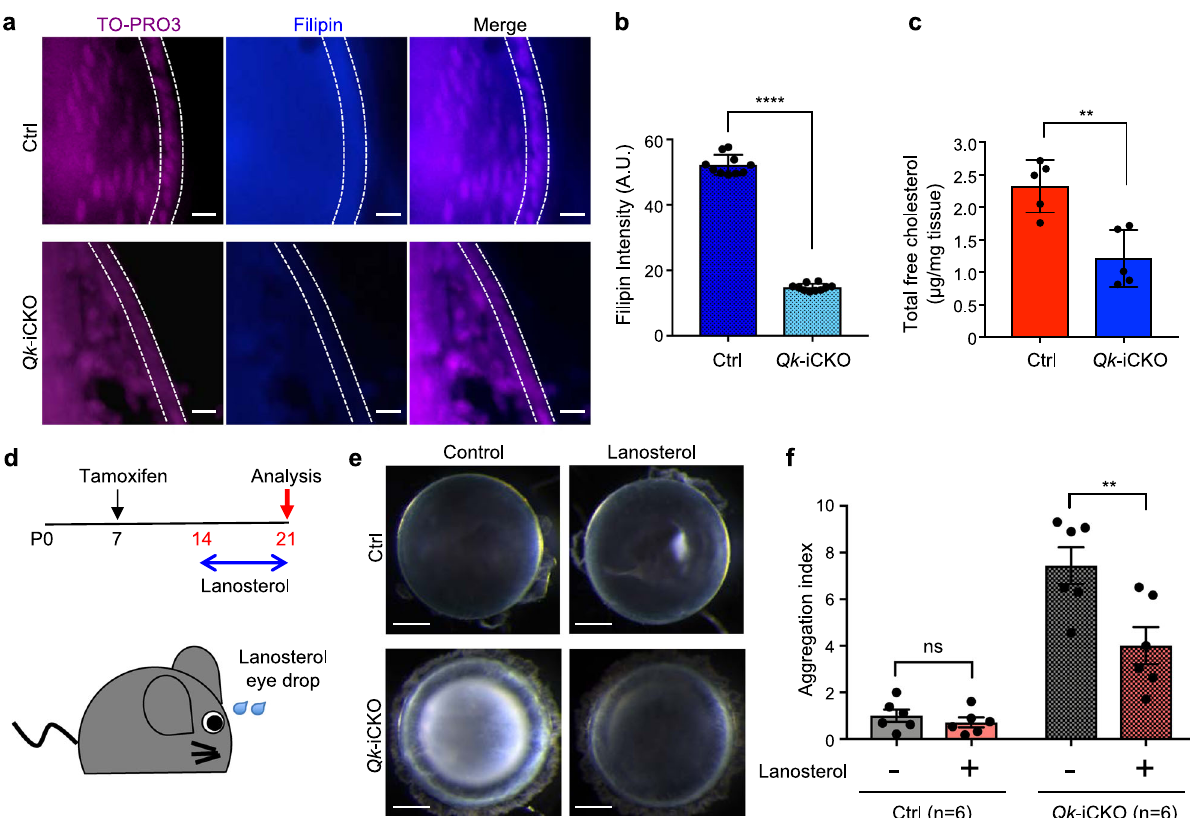
Fig. 3 Cholesterol levels are decreased in Qki-depleted lenses, and sterol supply alleviates the cataract phenotype in the lenses of Qk -iCKO mice. a Filipin (blue) staining of lens cells from frozen sections of the eyes of Ctrl and Qk- iCKO mice at P19. TO-PRO3 (magenta): nuclei. Scale bar: 10 μ m. b Quanti fi cation of fi lipin intensity (A.U.) in the regions between the white dotted lines in Ctrl and Qki-depleted lenses shown in a . **** p < 0.0001 (two- tailed unpaired t -test). The results are presented as means with SD. 10 cells from the images shown in a are counted for quanti fi cation. Each dot represents the intensity of individual cells. c Quanti fi cation of total free cholesterol levels ( μ g/mg tissue) in lenses isolated from Ctrl ( n = 5) and Qk -iCKO ( n = 5) mice at P19. p = 0.0032, ** p < 0.01 (two-tailed unpaired t -test). The results are presented as means with SD. d Timeline and schematic of lanosterol-based treatment in mice. e Representative images of lenses isolated from Ctrl and Qk -iCKO mice given either mock (control) or lanosterol-based treatment for 1 week. Scale bar: 0.5 mm. f Quanti fi cation of the area of protein aggregates from isolated Ctrl ( n = 6) and Qk -iCKO ( n = 6) lenses after mock and lanosterol-based treatment. Aggregation index = x/average of the area of aggregates in Ctrl lenses with the mock treatment. x = area of aggregates. p = 0.1668 (Ctrl); 0.0014 ( Qk -iCKO), ** p < 0.01; ns not signi fi cant ( p ≥ 0.05) (two-tailed paired t -test). The results are presented as means with standard error of the mean (SEM). All the experiments were replicated three times in the